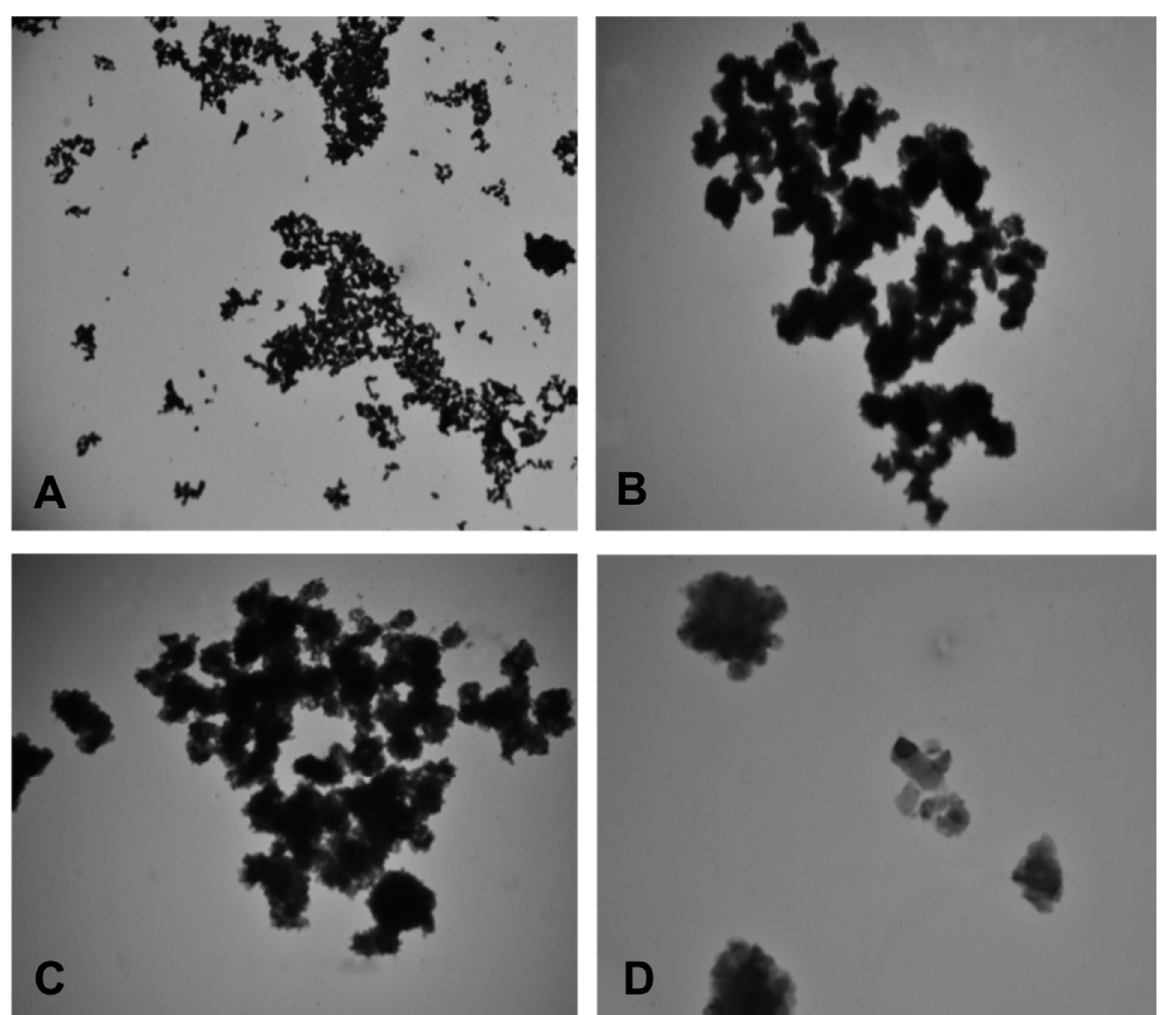
Figure 3. Electron micrographs of Cu-NPs at different magnifications, namely at ( A ) 8K DSC_2273, ( B ) 30K DSC_2278, ( C ) 50K DSC_2280, and ( D ) 80K DSC_2286.